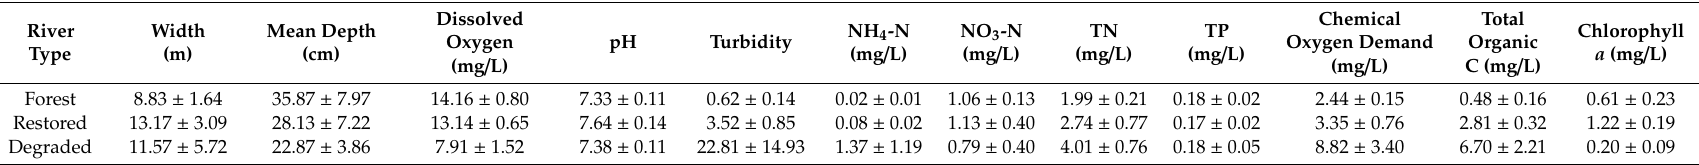
Table 1. Mean values of physico-chemical variables in di ff erent types of rivers within the Anji City Region, PRC. The values represent the mean ± standard error of three replicate samples.